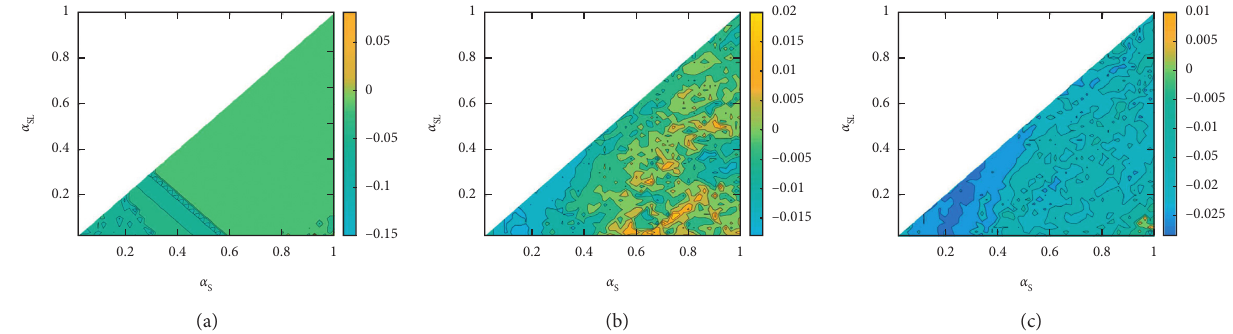
Figure 15: LLE diagram of supply chain nodes under the scenario of random demand obeying normal distribution from local perspective � 5. (a) The retailer’s LLE chart. (b) The LLE chart of the distribution center. (c) The LLE chart of the combined system when G d � 2 and G 1 from the decision